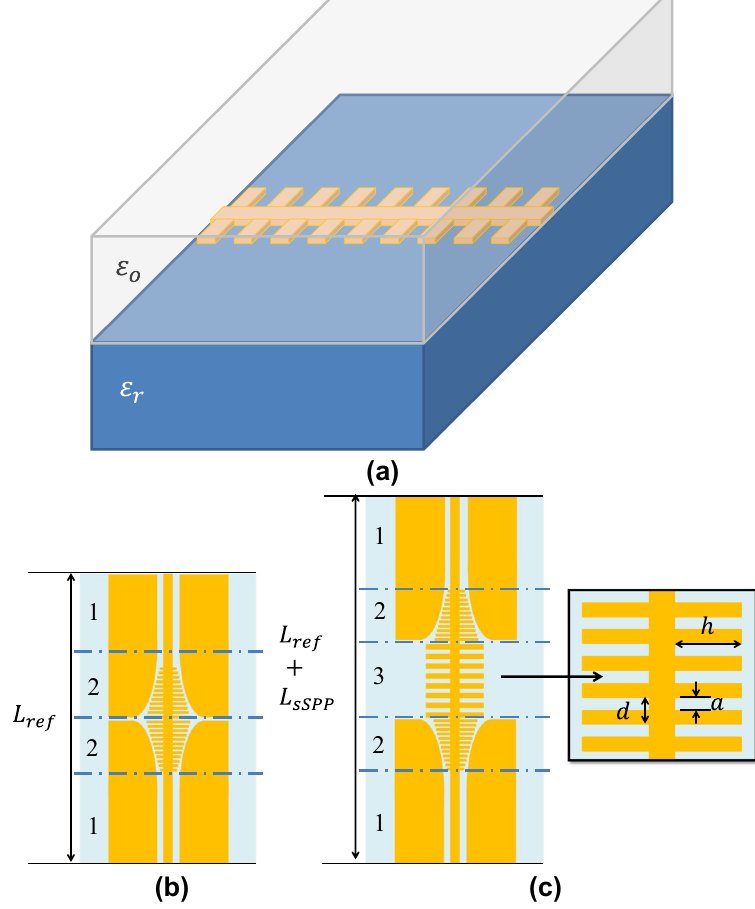
Figure 1. The schematic of the corrugated planar sSPP WG ( a ). The layout of the reference line ( b ) and the sSPP delay line with cell dimensions ( c ). In the waveguides, (1) corresponds to the coplanar waveguide sections, (2) to the transition sections and (3) to the sSPP delay sections (3). The physical dimensions of the sSPP WGs (corrugation depth ( h ), periodicity ( d ) and aperture width ( a )) are also